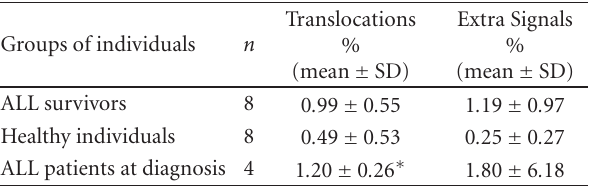
Table 5: Mean frequency of BCR/ABL translocations and extra signals obtained for ALL survivors, healthy individuals, and patients at the time of initial